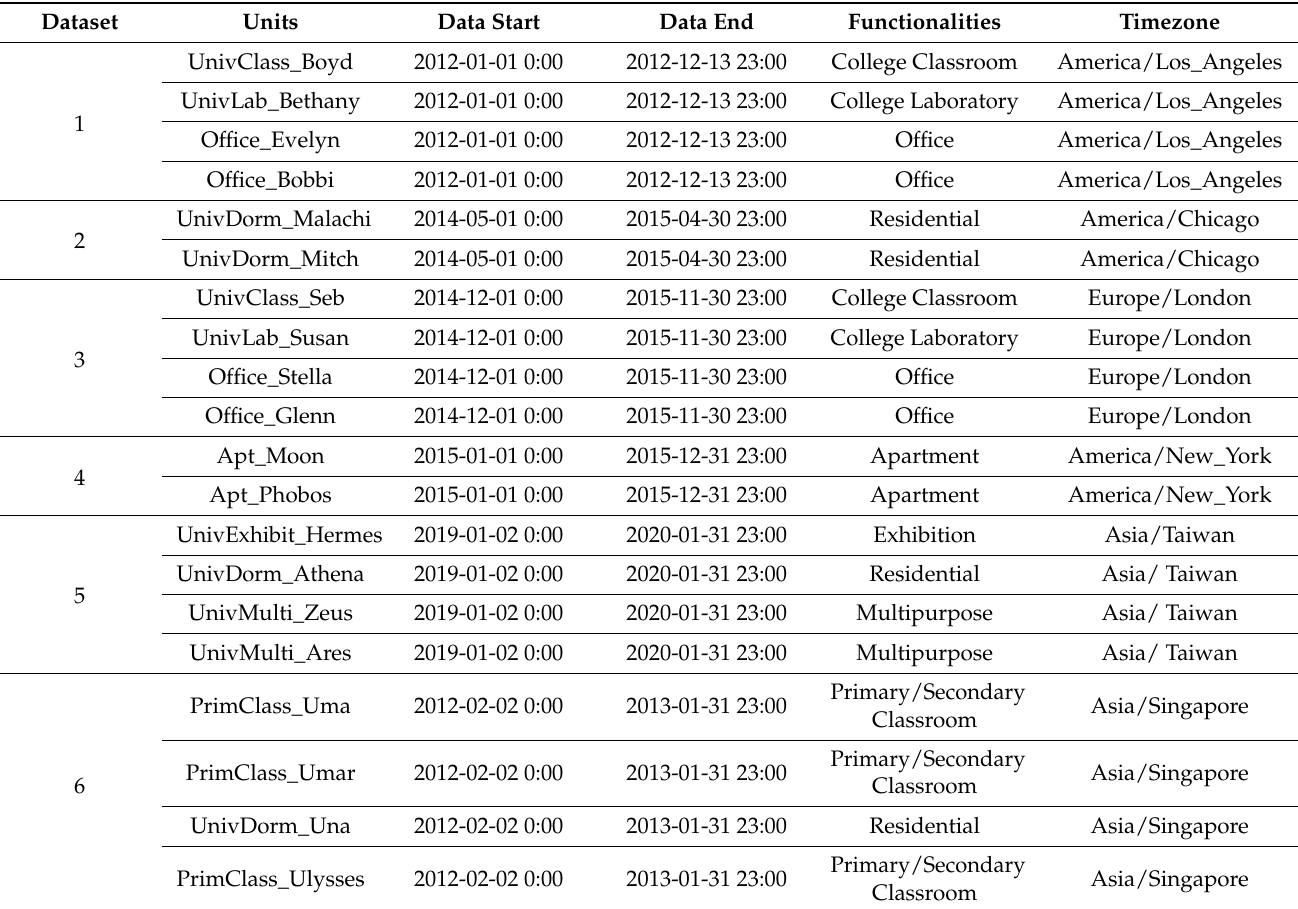
Table 2. Dataset